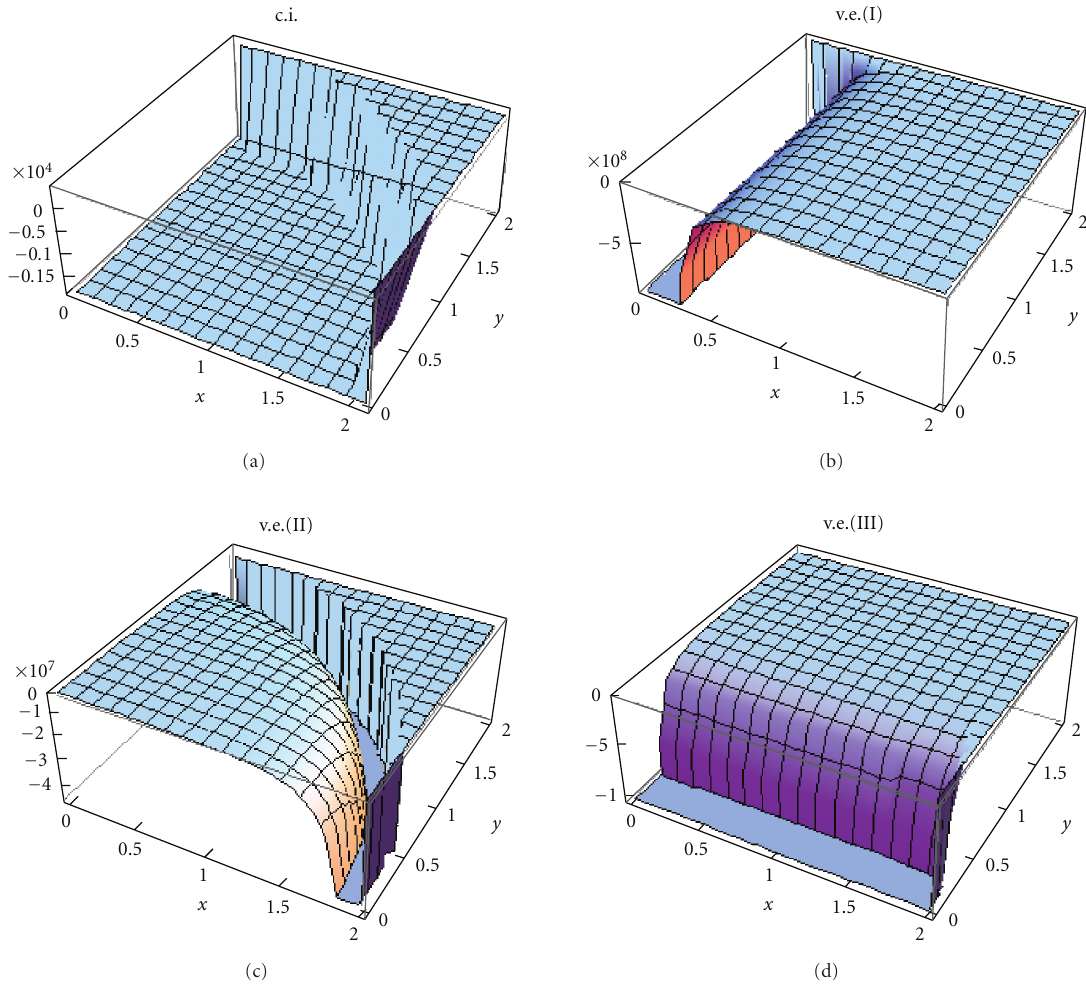
Figure 4: Plots of the isotropic functions appearing in the vector fields trispectrum (from (55)): c.i. is the contribution from contact- interaction diagrams, v.e. ( I ), v.e. ( II ), and v.e. ( III ) are the contributions from the vector-exchange diagrams. The equilateral configuration has been considered in this